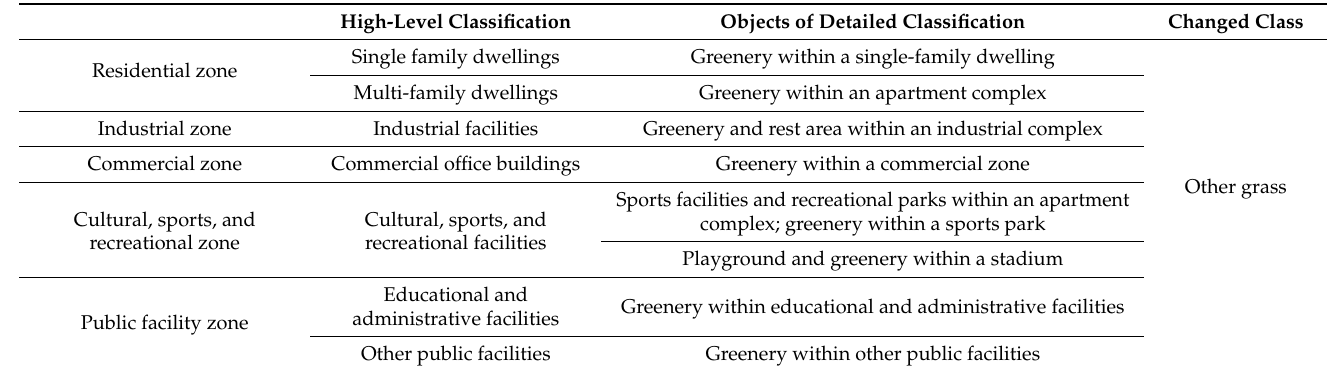
Table 2. Definitions of the landcover items reclassified in